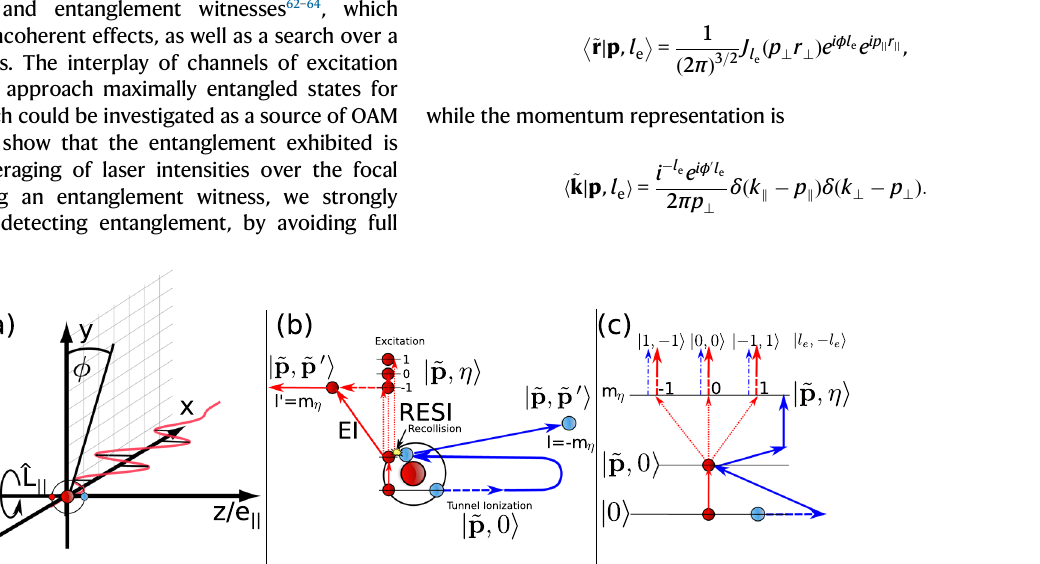
states are de fi ned in the text, following the convention of ref. 66. c The excitation pathways in RESI, which lead to different fi nal OAM states and an entangled (cid:1) asusedin(8).The superposition.The fi nalstatesaregivenbyOAMstates, ∣ l e , (cid:3) l e dashed-dotted lines are to denote, which two-electron state the fi rst electron ends upin.Thenumbers − 1,0,1refertothevaluesofthequantummagneticnumber m η (cid:1) of the intermediate excited state, ∣ ~ p , η